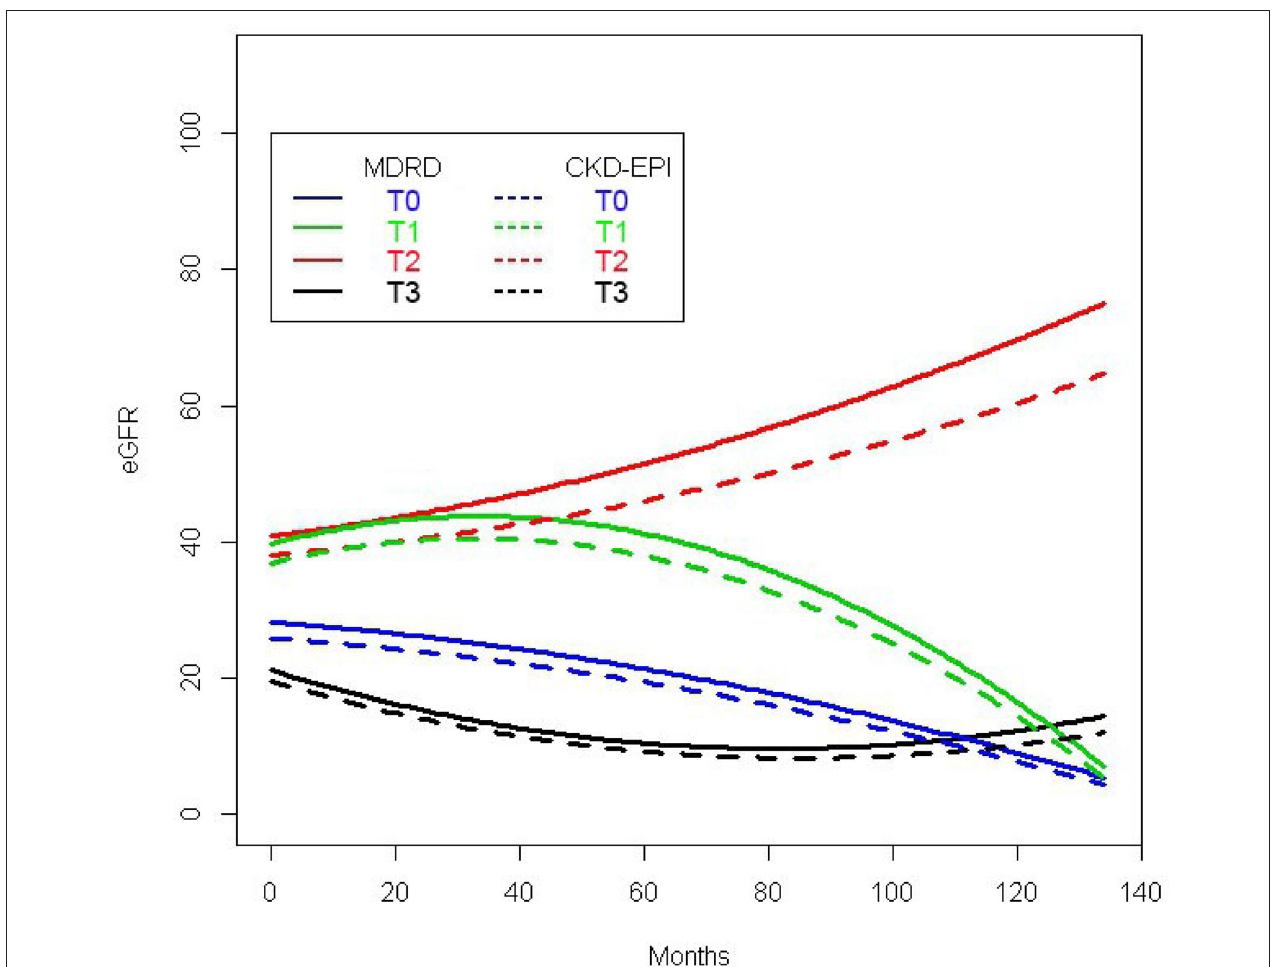
FIGURE 2 | Four eGFR trajectories in the CKD cohort. Pattern 1 (T0): solid blue line, gradual eGFR decline; pattern 2 (T1): solid green line, early non-decline and then persistent decline; pattern 3 (T2): solid red line, persistently increasing eGFR; pattern 4 (T3): solid black line, low baseline eGFR with the early decline and then progressively increasing eGFR. Four eGFR trajectories with the CKD-EPI equations were also shown (dotted blue, green, red, and black